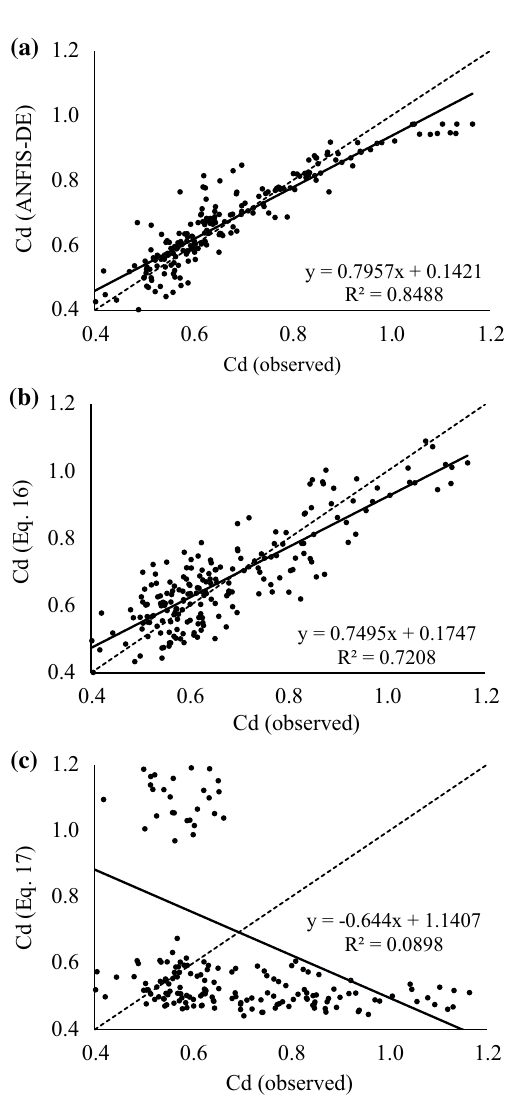
Fig. 12 Comparison between a ANFIS-DE & b the equations of Borghei and Parvaneh (2011) & c The equation of Emiroglu et al.